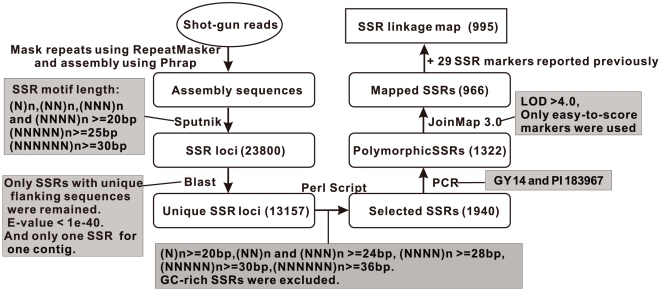
Flow chart of development of cucumber SSR markers.